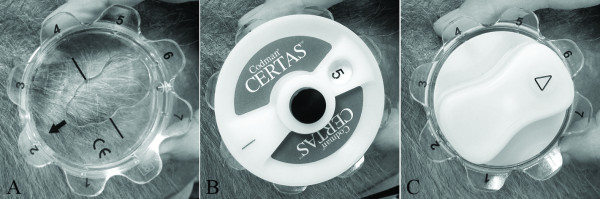
Therapeutic management system for the CertasTMvalve. Locater tool (A), indicator tool (B), and adjustment tool (C)